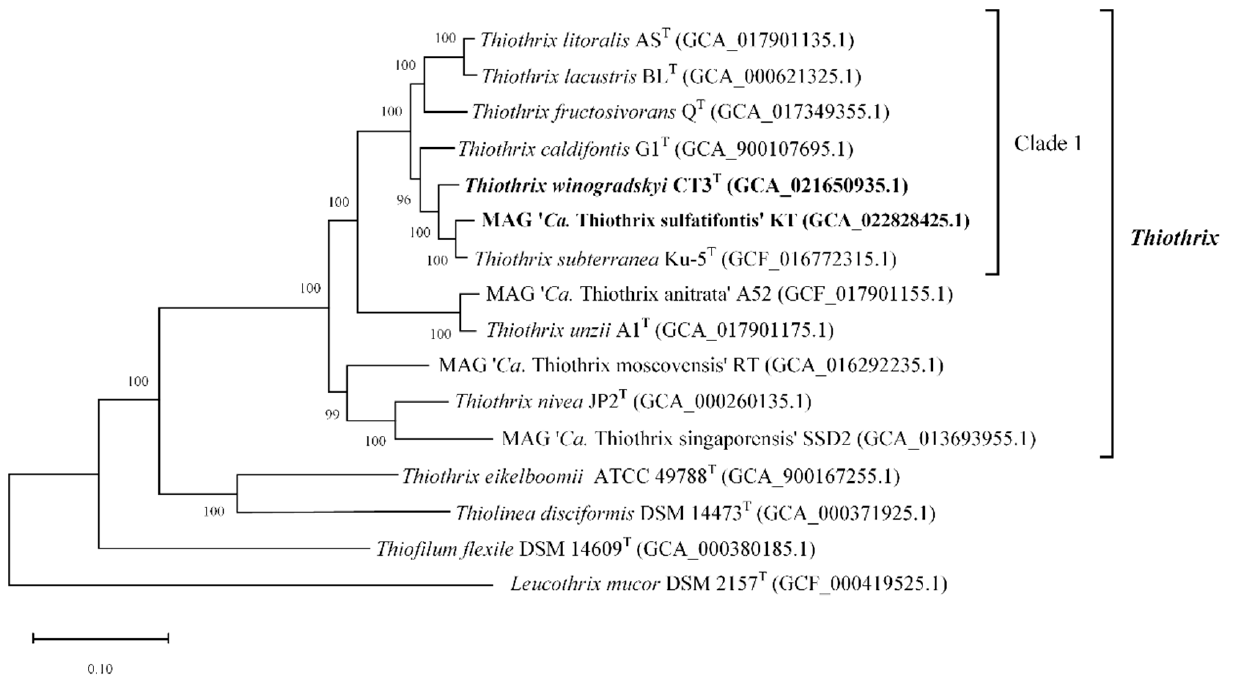
Figure 3. Genome-based phylogenetic tree of type strains of Thiothrix species. The GenBank assembly registration number is listed after the genome names. The internal branching support levels assessed by the Bayesian test in PhyML are specified in nodes. The genome of Leucothrix mucor DSM 2157 T was used for tree rooting. Note that Thiothrix eikelboomii actually should belong to the genus Thiolinea but cannot be reclassified because of its absence in two international collections